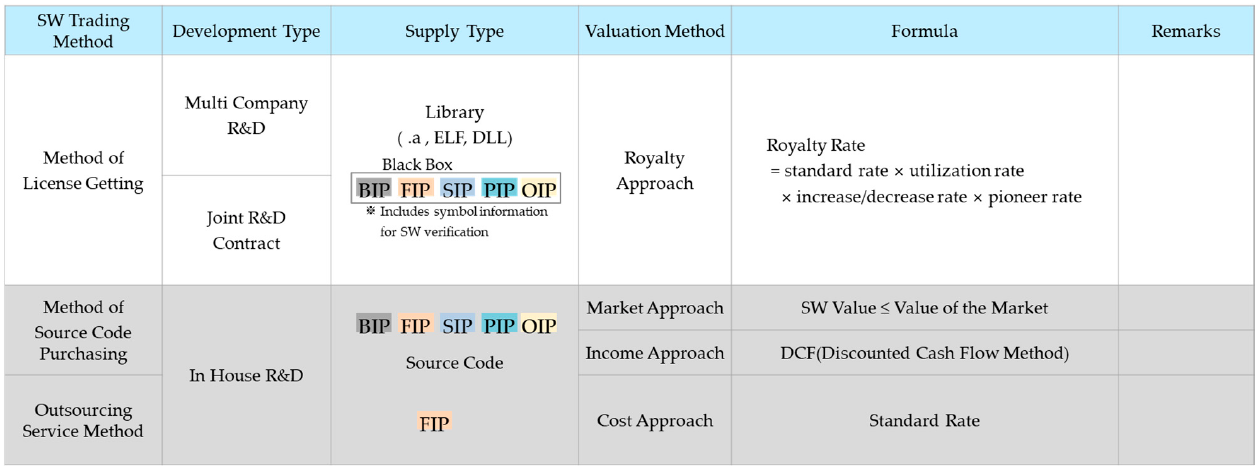
Figure 5. Type of Providing SW